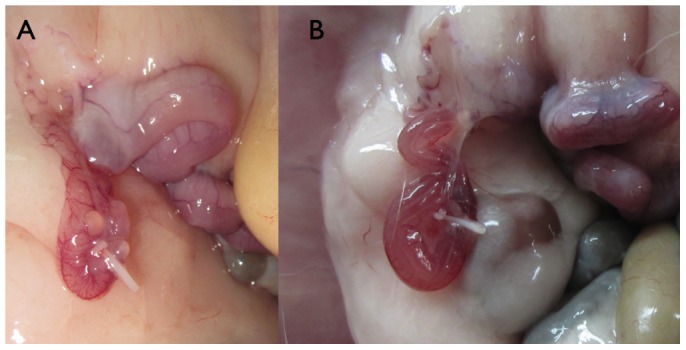
Representative oviduct ligation with a non-absorbable polymer locking clip (Hemo-o-lock® Ligation System) after transfer (48 h post ovulation induction) (A).Detail of intrauterine fluid retention after transfer (48 h post ovulation induction) (B).